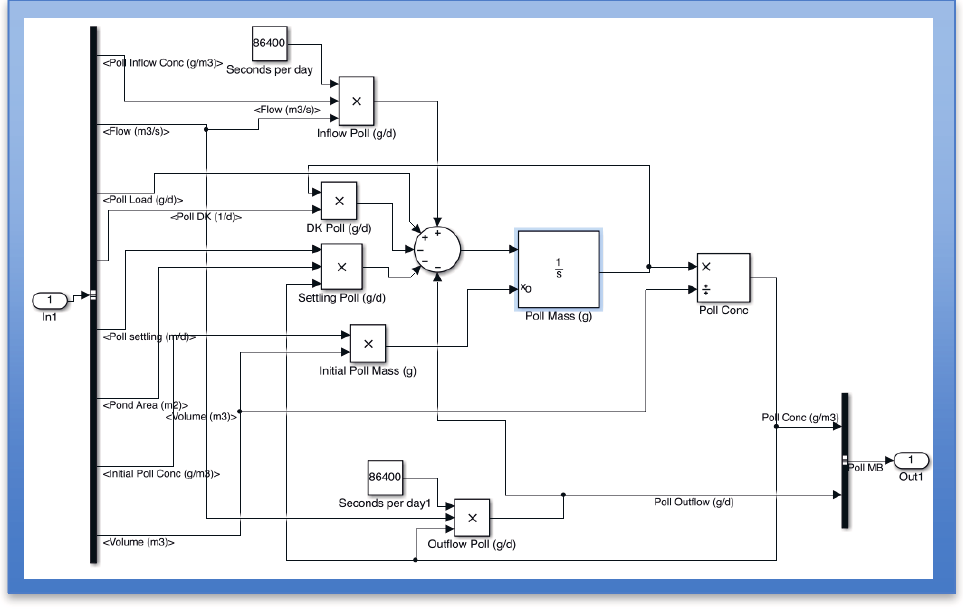
Figure 4. Simulink model of pond mass balance for a